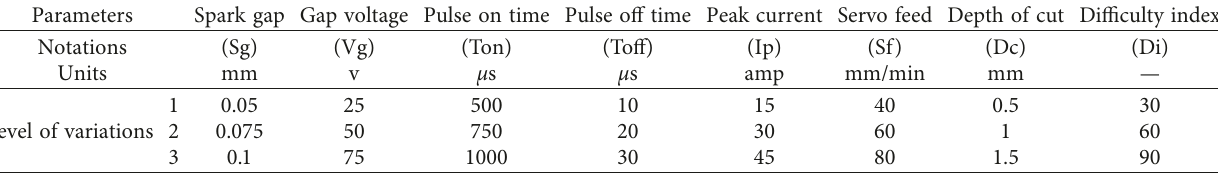
Figure 4: Electrode images at various stages. (a) Image of requisite machining performed on lathe on copper tool electrode. (b) Image of copper tool electrode after requisite machining performed and before starting experiment 1. Table 5: Domain of experiments: bounded machining process